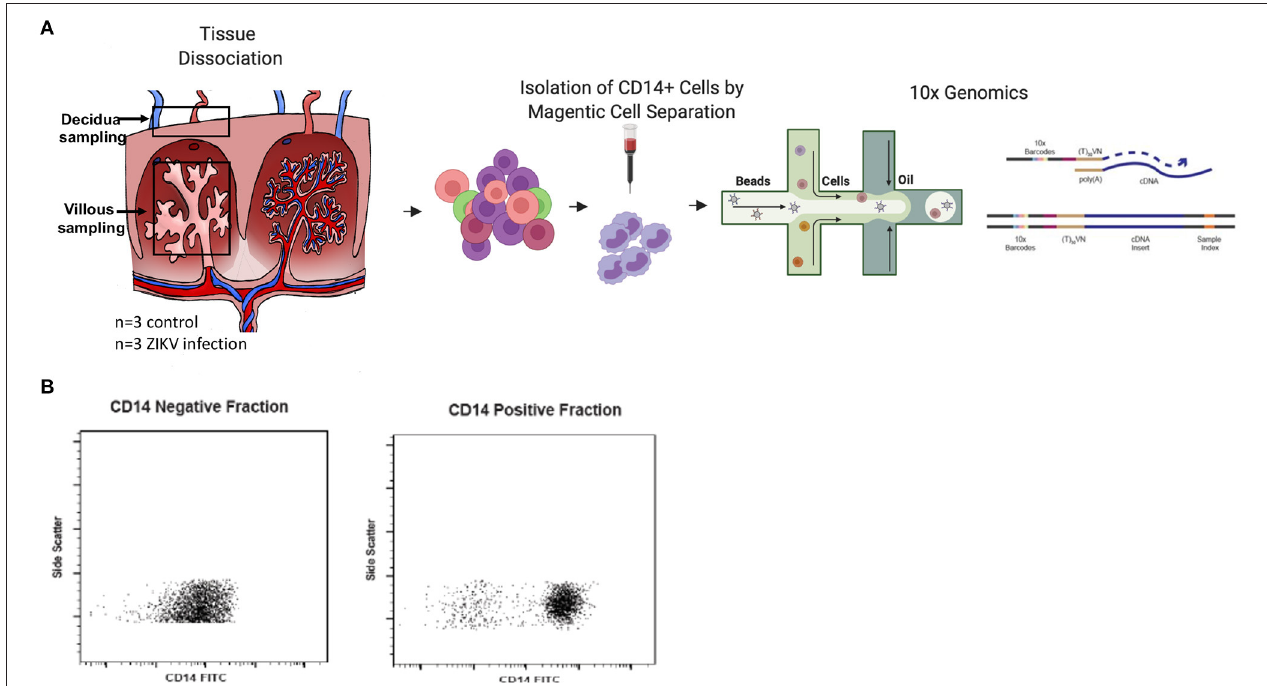
FIGURE 1 | Experimental design. (A) Decidua samples were collected after C-section delivery at G135 of pregnant dams either infected with ZIKV at G31, G51, or G115 or time matched uninfected control dams ( n = 3). Tissues were dissociated and processed to single cells. For isolation of CD14 + cells, cells were positively selected using CD14 + microbeads and magnetic cell separation. Isolated cells were loaded into a 10x Genomics Chromium instrument and libraries were sequenced using Illumina chemistry. Resulting sequence data was processed using cell ranger software and further analyzed in the Seurat software package of R. (B) Both the CD14 + positive cells and negative flowthrough cells were analyzed by flow cytometry to determine purity of the CD14 + cell